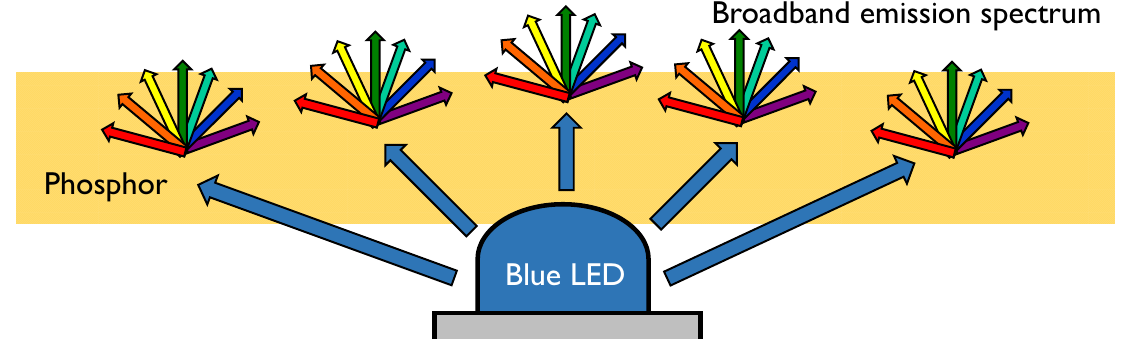
Figure 4. Working principle of a broadband LED emitter [23]: a blue LED is used to illuminate a piece of phosphor which then emits a wide spectrum. Some of the original blue light also goes